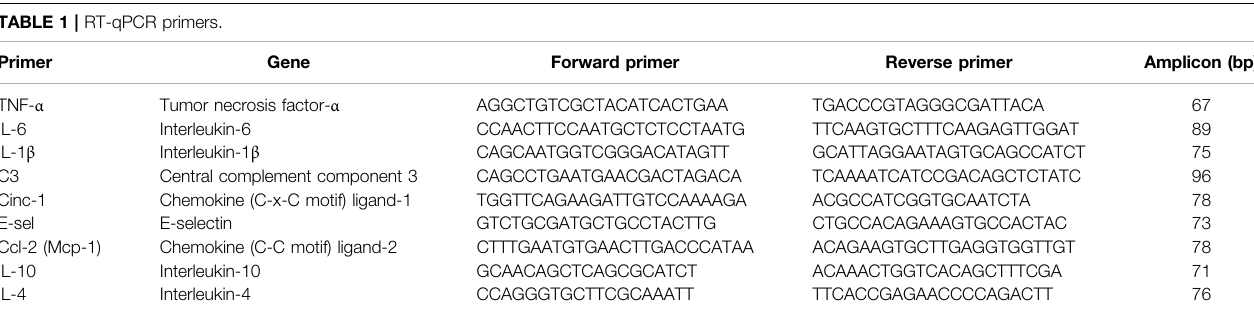
TABLE 1 | RT-qPCR